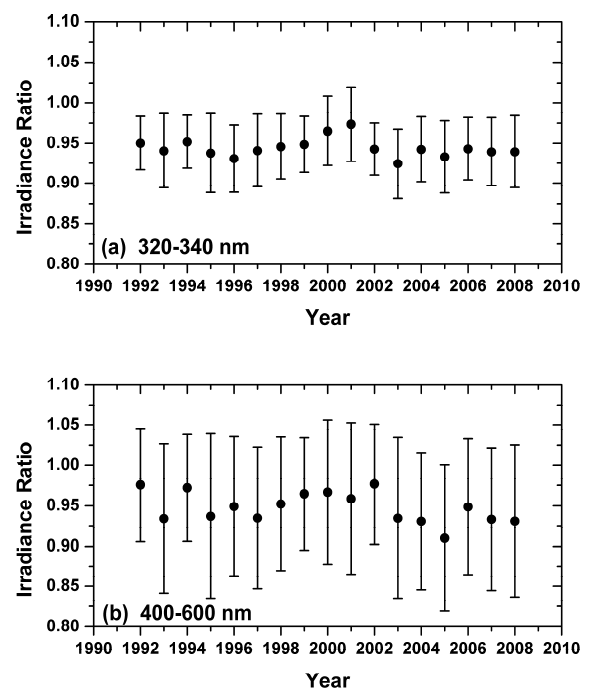
Fig. 7. Statistical summary of irradiance ratios for each solstice period: dots are mean irradiance ratios. Error bars are plus and minus one standard deviation and indicate the variability associated with cloudiness. (a) 320–340nm wavelength band. (b) 400–600nm wavelength